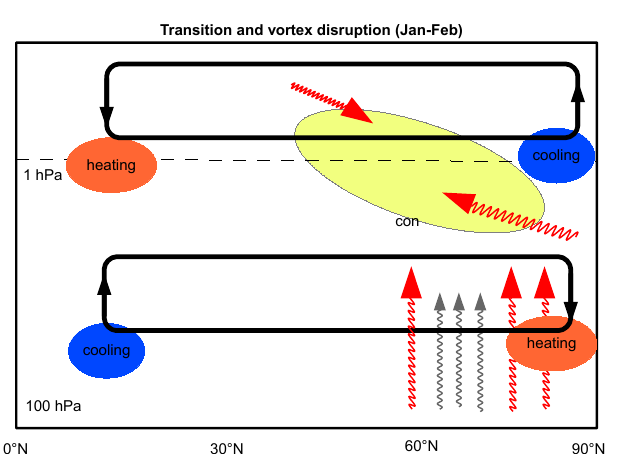
Figure 7. Solar cycle modulation of the winter circulation: schema of the related mechanisms. The upper and lower figure show early and later winter respectively. The heating and cooling anomalies are drawn with red and blue boxes. The EP flux divergence and conver- gence are drawn with green and yellow boxes. The wave propaga- tion anomaly is expressed as a wavy red arrow in contrast to the climatological average drawn by a wavy grey arrow. The induced residual circulation according to the quasi-geostrophic approxima- tion is highlighted by the bold black